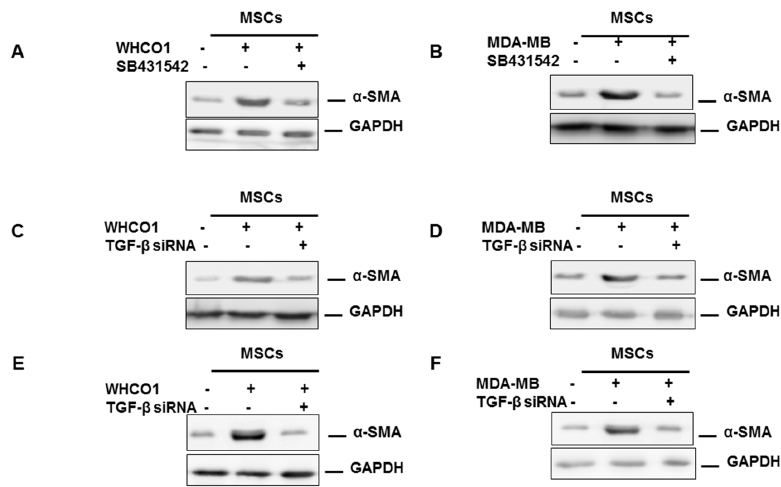
Figure 4. WHCO1, MDA MB 231 cells and MSCs secrete TGF- β . Mesenchymal stem cells (5 × 10 5 cells) were cultured in the upper insert and cancer cells (WHCO1 and MDA MB 231) (5 × 10 5 cells) were